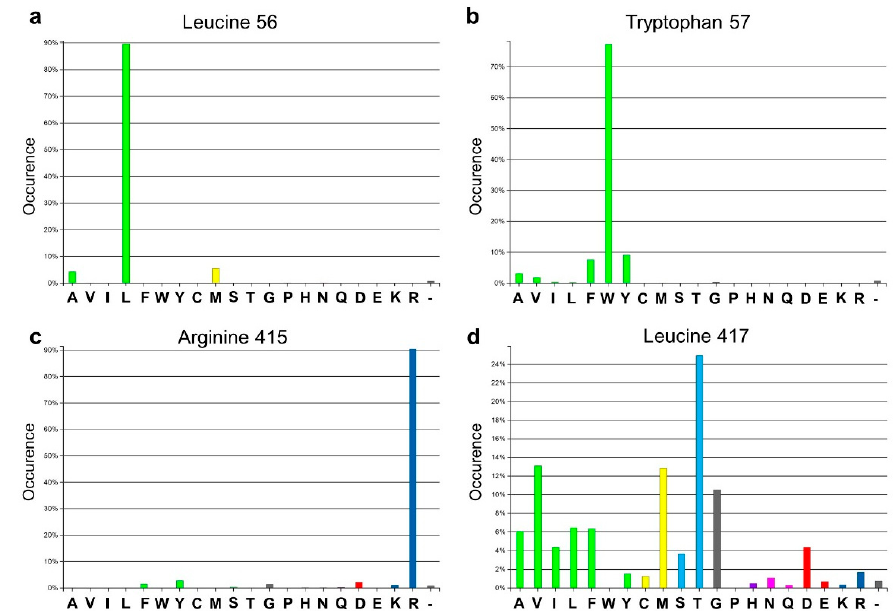
Figure 1. Amino acid distribution of the four target sites in the Vibrio fluvialis amine transaminase (VF-ATA) library. The amino acid distribution is based on the sub-dataset created by 3DM. ( a ) Amino acid distribution for leucine 56 (3DM No. 46); ( b ) amino acid distribution for tryptophan 57 (3DM No. 47); ( c ) amino acid distribution for arginine 415 (3DM No. 346); ( d ) amino acid distribution for leucine 417 (3DM No. 348). Colors define amino acids with the same or different physicochemical properties, respectively.